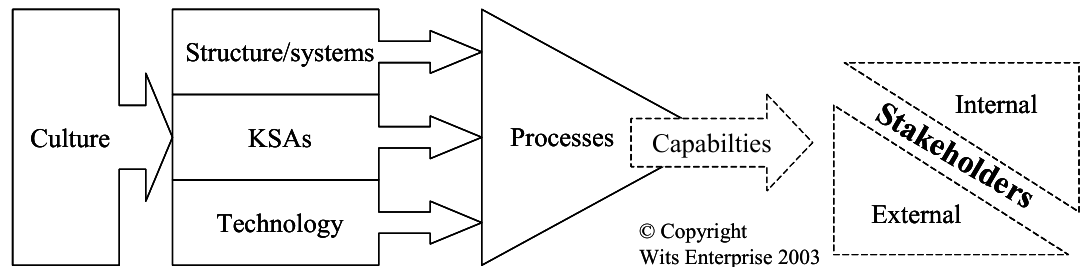
Figure 1: Reading from the right: In this architecture, capabilities are delivered to stakeholders through processes. Processes are enabled by structure and systems, KSAs (knowledge, skills and abilities) and technology. Finally, culture underlies all other